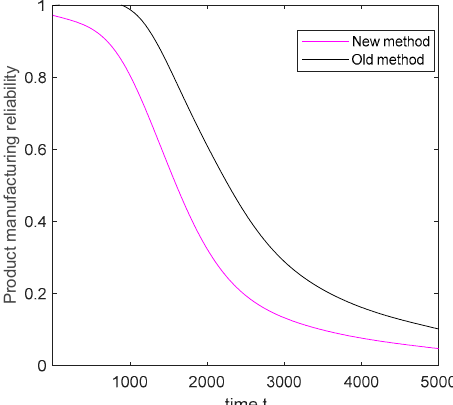
Figure 10. Comparative analysis of camshaft manufacturing reliability.